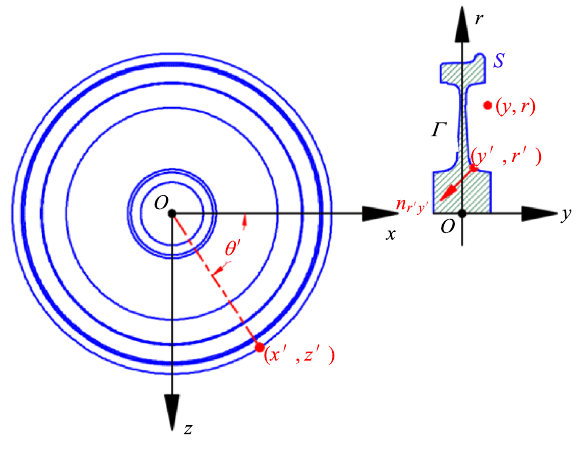
Fig. 3 Acoustic structure of a